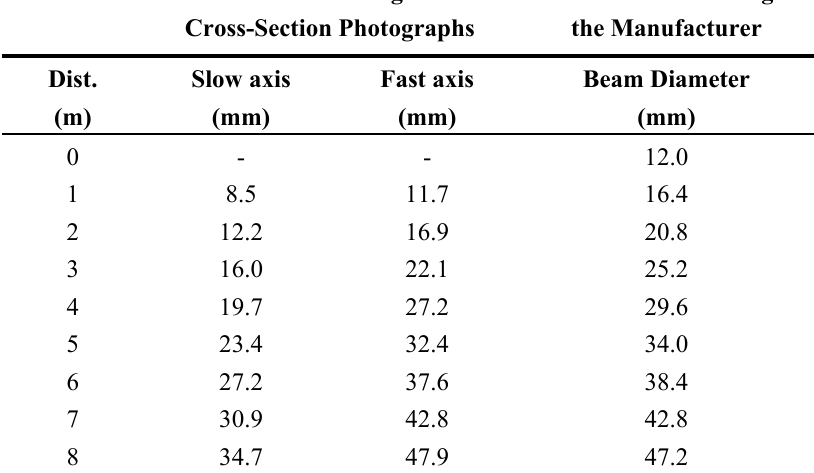
Table 1. Dimensions of the LMS200 sensor laser beam according to the laboratory tests and according to the information supplied by the manufacturer [16]. Dimensions According to Beam Dimensions According to Cross-Section Photographs the Manufacturer Dist. Slow axis Fast axis Beam Diameter (m) (mm) (mm) (mm) 0 - -